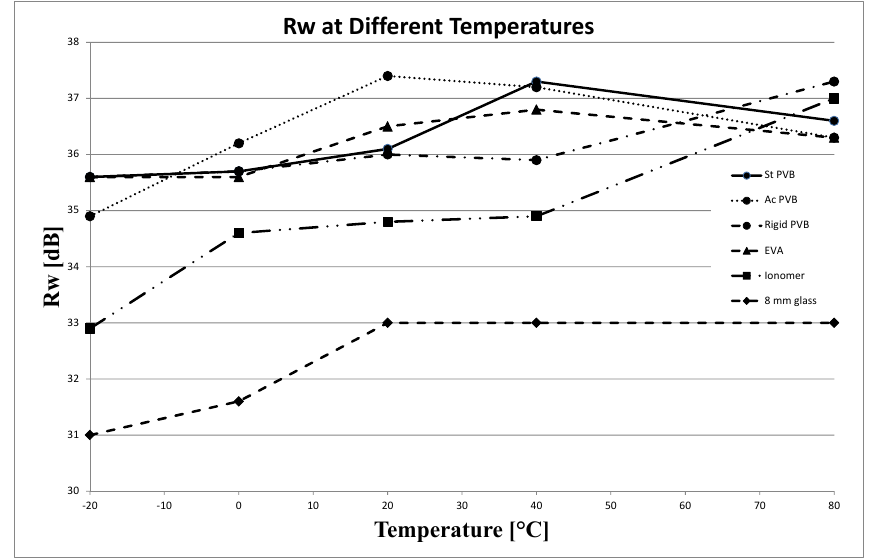
Fig. 11 Weighted Sound Reduction Index (Rw) at different temperatures